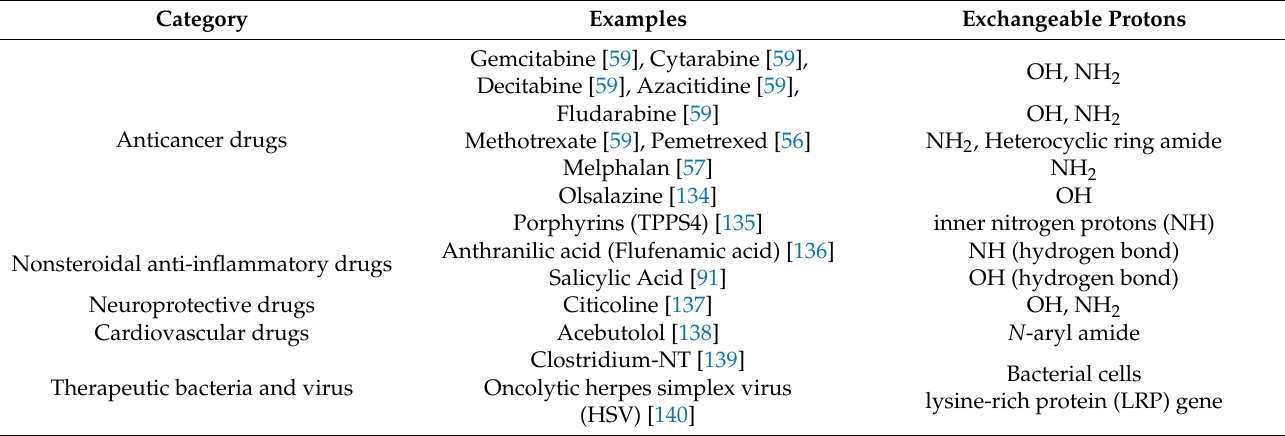
Table 2. Examples of drugs that can be off-label used drugs as CEST